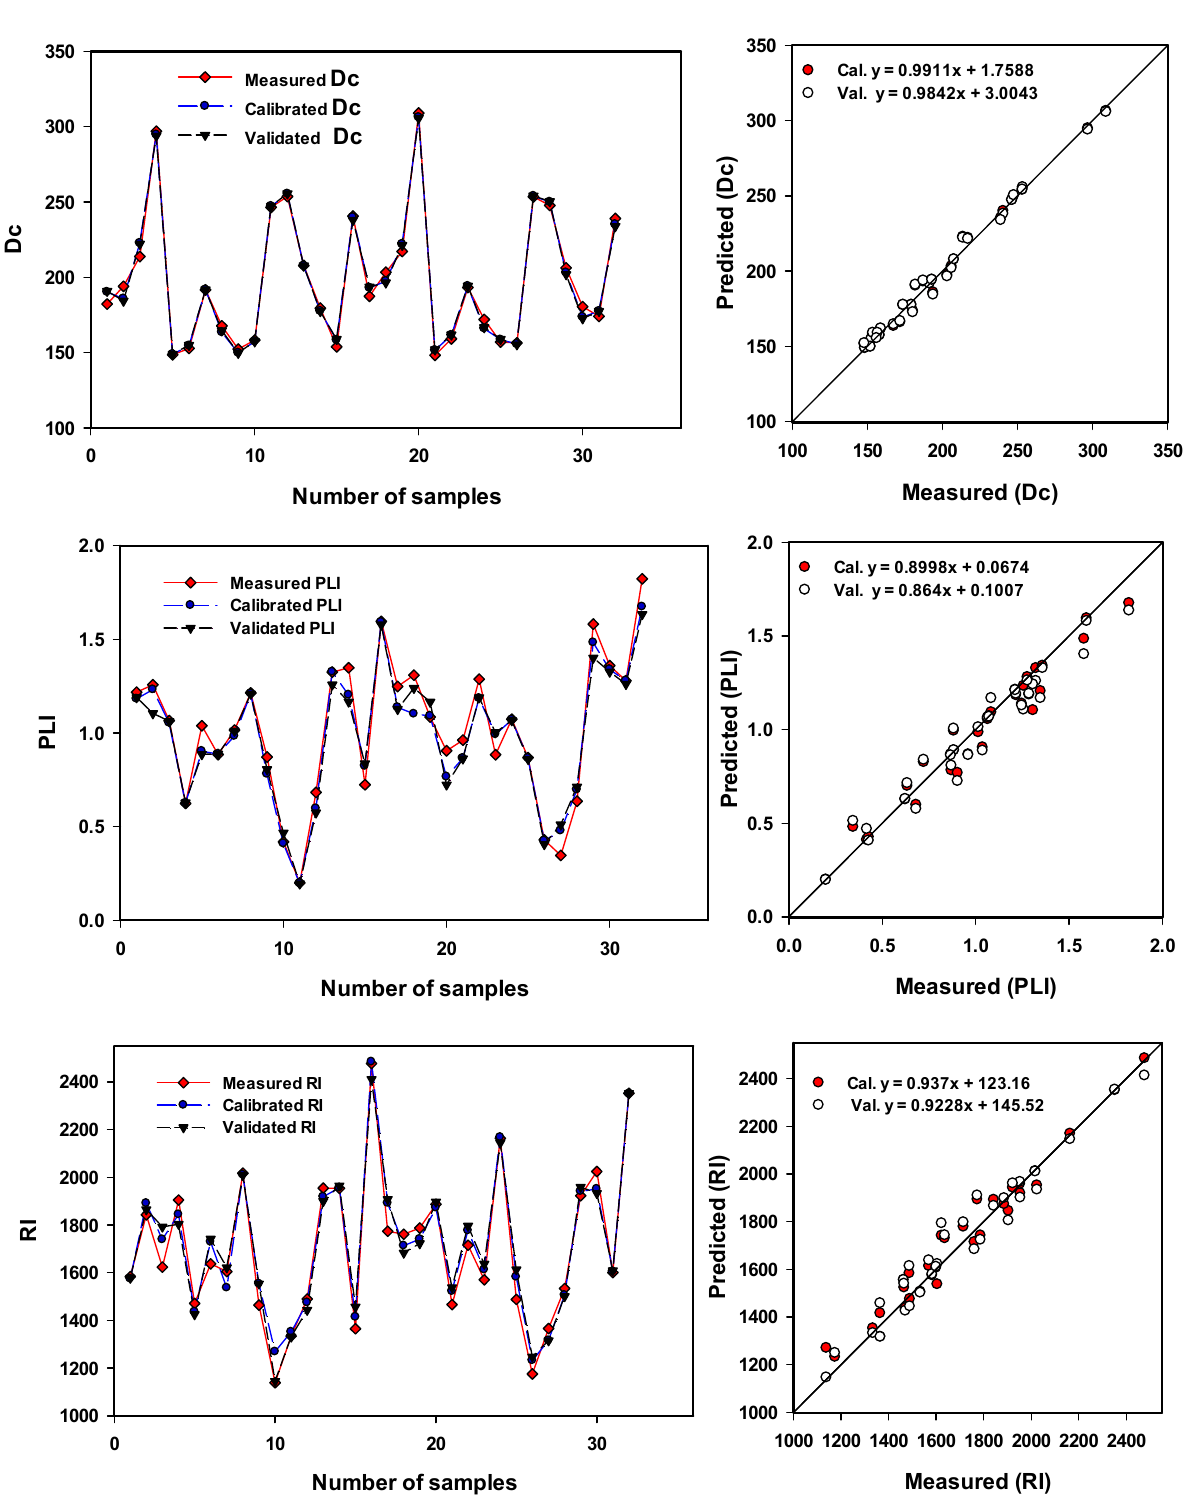
Figure 7. Comparison between measuring datasets, calibrating datasets, and validating datasets for three pollution indices index using the PLSR models based on several heavy metals. Statistical analysis was showed in Table 9.